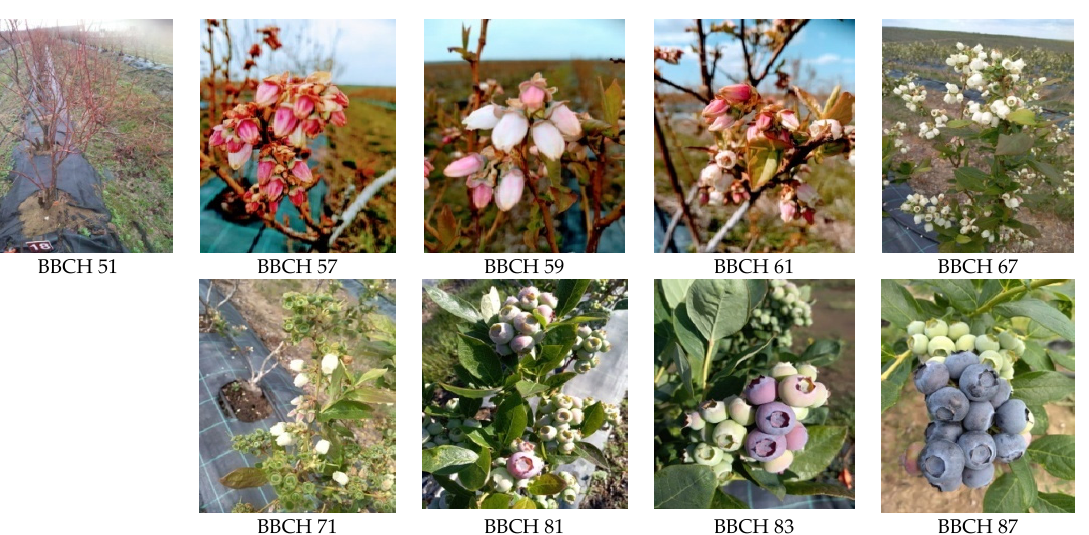
Figure 2. Stages of generative development in blueberry (original) Statistical analysis. Analysis of variance ANOVA (SINGLE FACTOR ANOVA) was used to analyse within-group and between-group variance and the grand mean (overall mean). The JASP 0.15.3 and Excel 2019 programs were used. With the JASP 0.15.3 pro- gram, descriptive analyses of the data and analysis of variance ANOVA were carried out, and to determine the significance of the results, the post hoc P Tukey analysis was used.